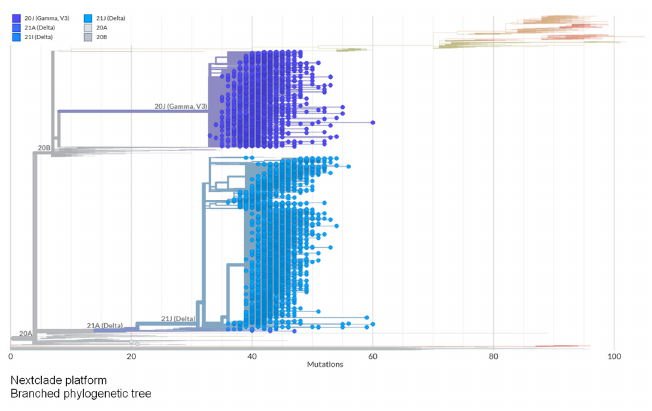
Figure 9. Phylogenetic tree of SARS-CoV-2 variants (high-resolution image can be found in supple- mentary material).